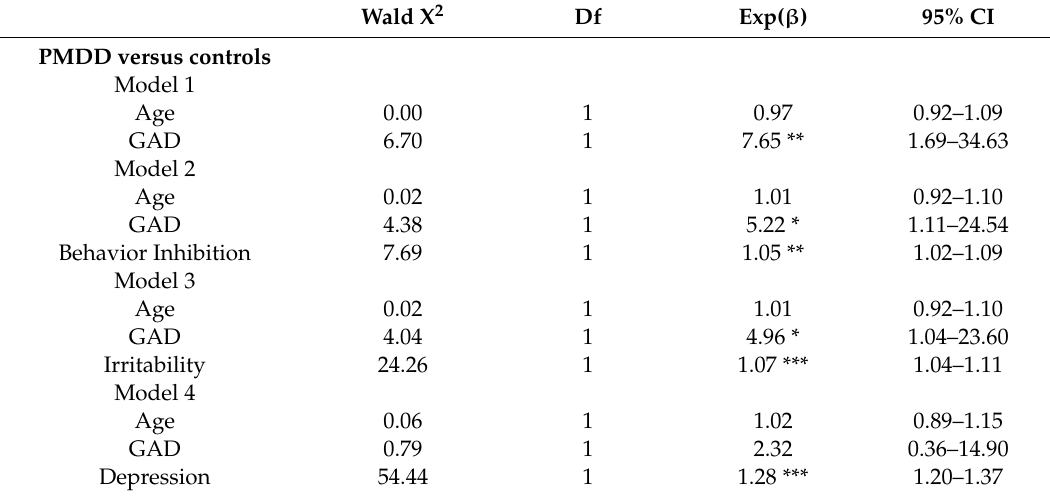
Table 2. Hierarchical logistic regression to evaluate the association between premenstrual dysphoric disorder and generalized anxiety disorder (GAD), after controlling for behavior inhibition or